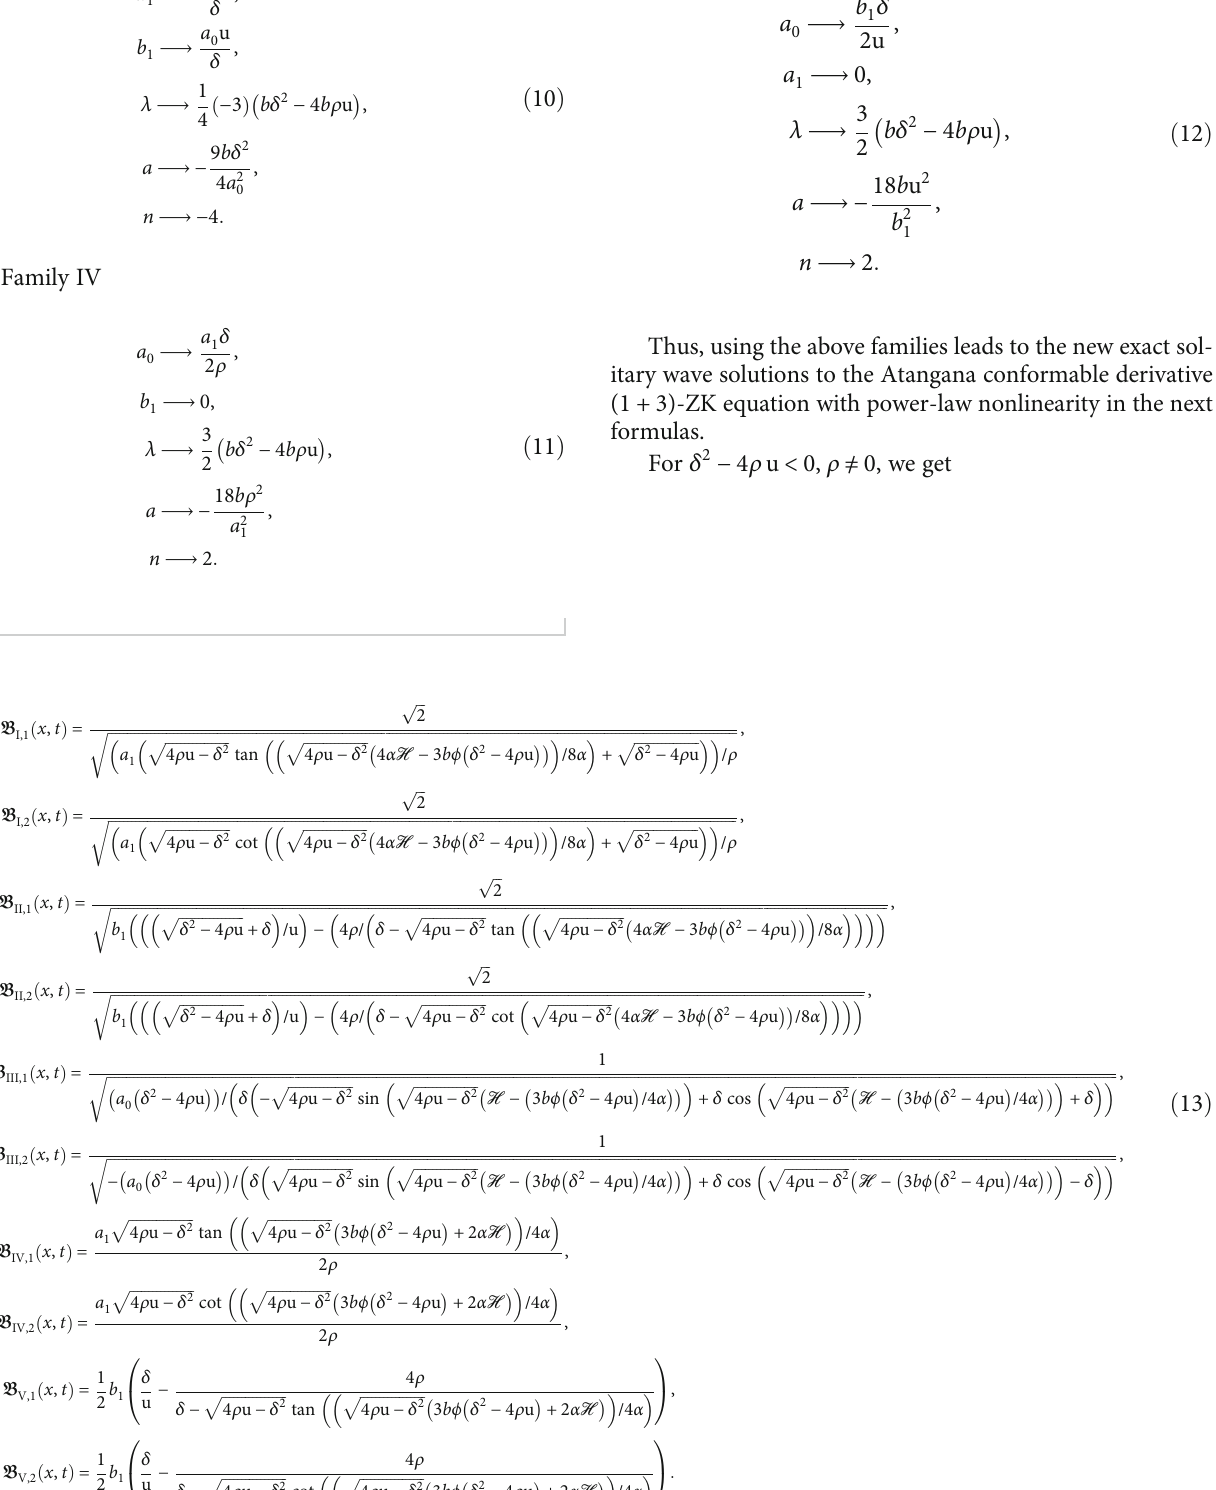
p ffiffiffiffiffiffiffiffiffiffiffiffiffiffiffiffiffi ffiffiffiffiffiffiffiffiffiffiffiffiffiffiffiffiffi δ − 4 ρ u − δ 2